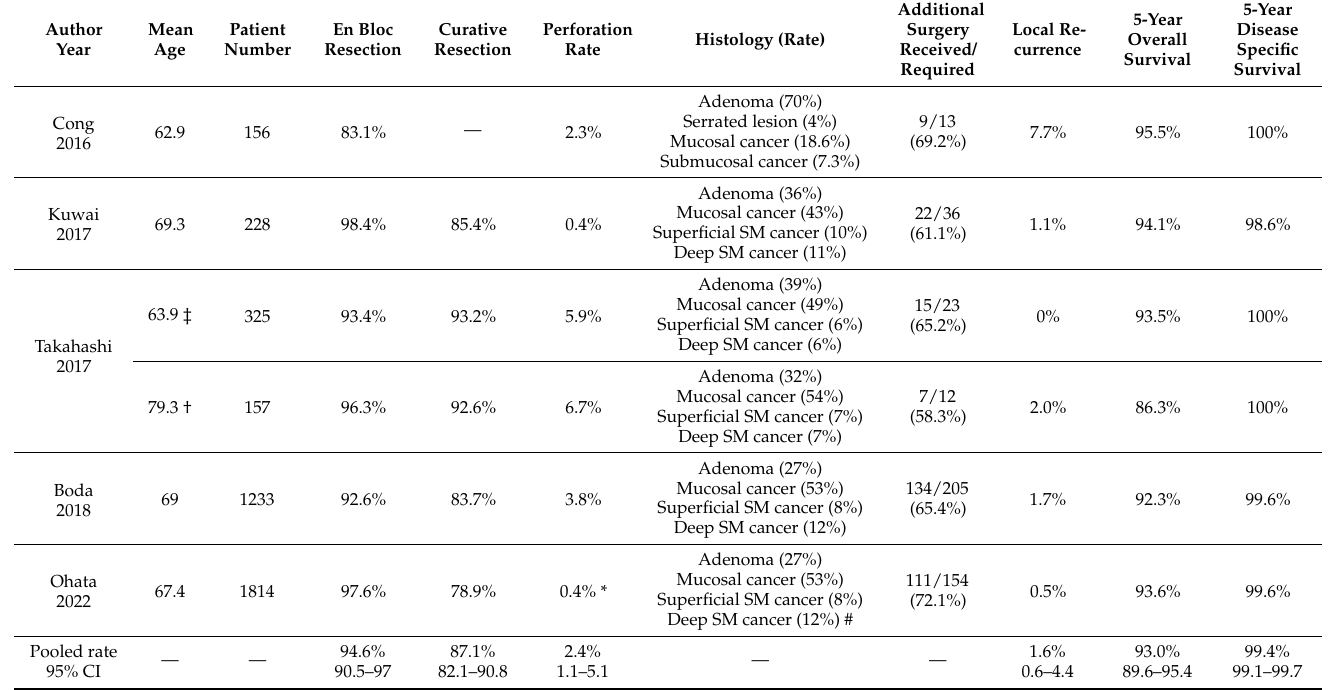
Table 1. Five-year overall survival and 5-year disease-specific survival after colorectal endoscopic submucosal